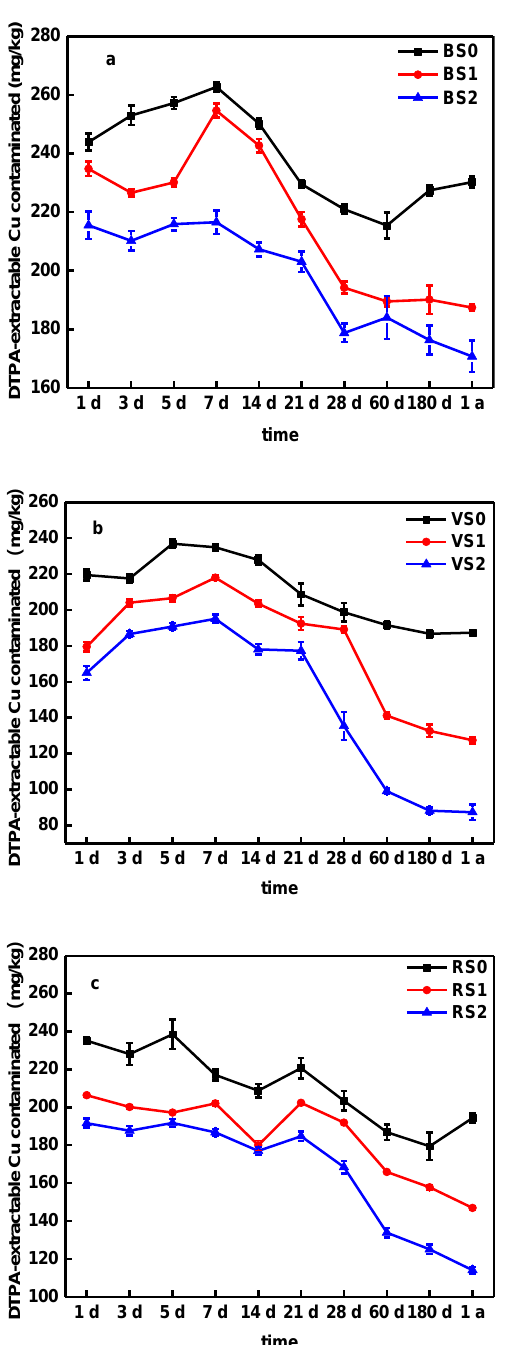
Figure 5. The change of DTPA-extractable Cu concentration in BS ( a ), VS ( b ) and RS ( c ) soils amended with biochars. Note: Error bars are standard deviations of the means ( n = 3).